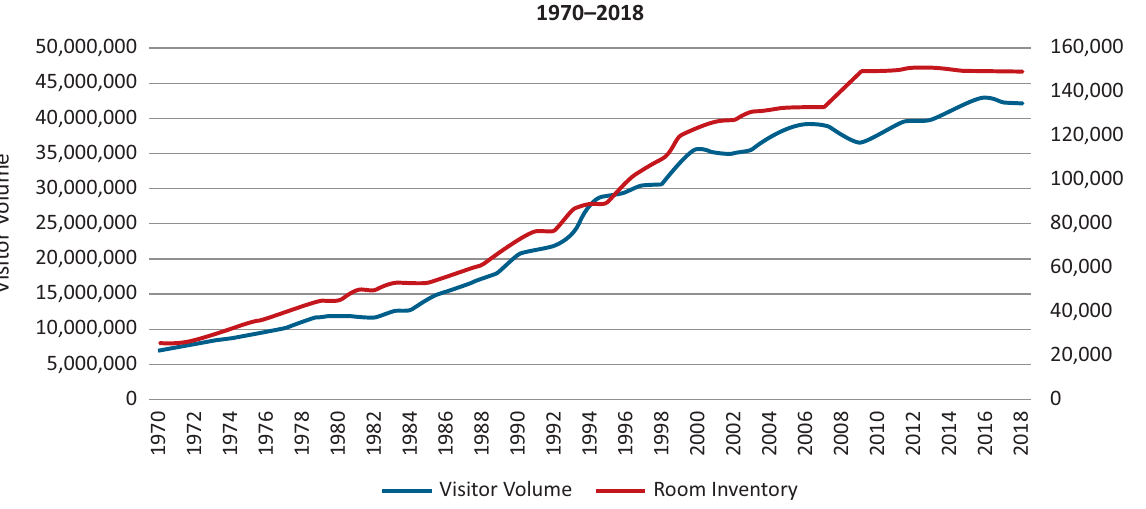
Figure 4. As this graph from the period 1970–2018 indicates, in Las Vegas visitor volume has tended to rise with hotel room inventory, pointing to induced demand. Source: Las Vegas Convention and Visitors Authority Research Center